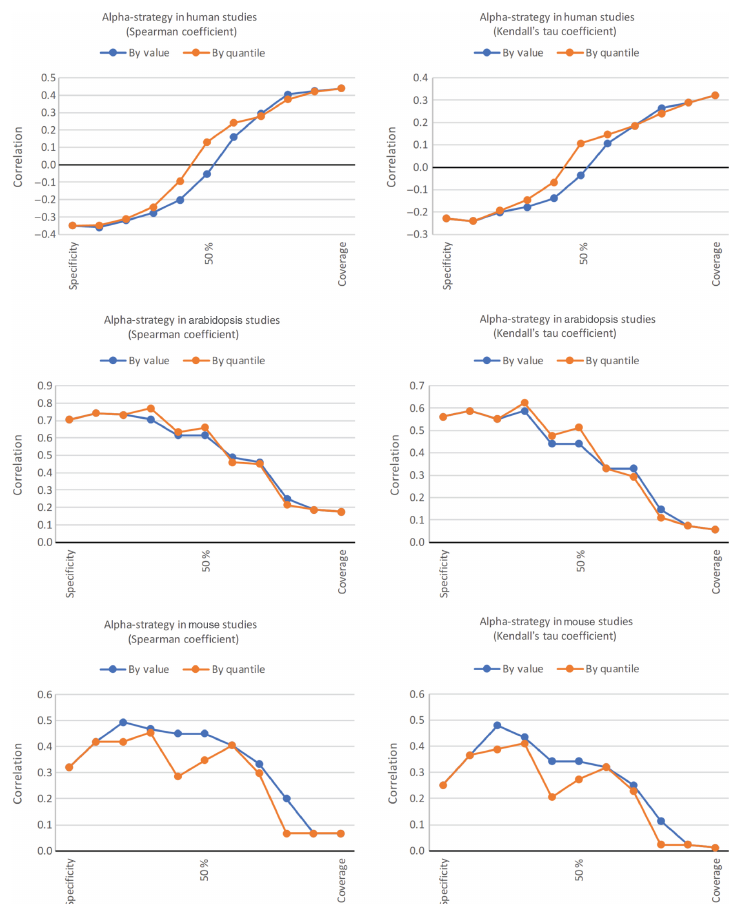
Figure 7: Correlation between the manual rankings and the automatic ones. This figure includes the results for the Homo sapiens rankings (top), the Arabidopsis thaliana rankings (middle), and the Mus musculus rankings (bottom). On the left, we illustrate the Spearman ’ s ρ correlation coefficient; on the right the Kendall ’ s τ coefficient. On each graph, the α value runs from 0.0 to 1.0 in steps of 0.1, where 0.0 corresponds to a ranking based solely on the Specificity measure, and 1.0 corresponds to a ranking based solely on the Coverage measure. The midpoint is labelled 50